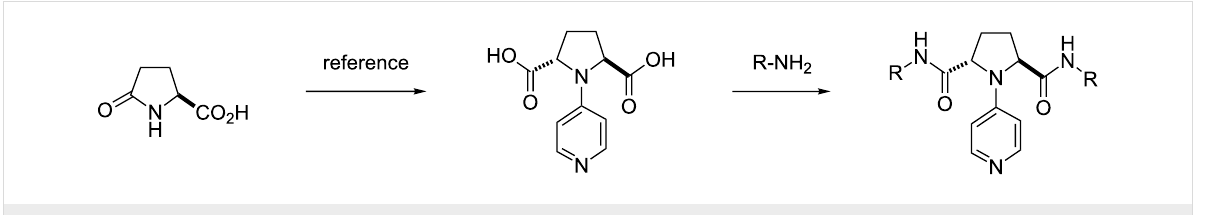
Scheme 2: Preparation of a small library of chiral C 2 -symmetric PPY catalysts (reference, see [12]).